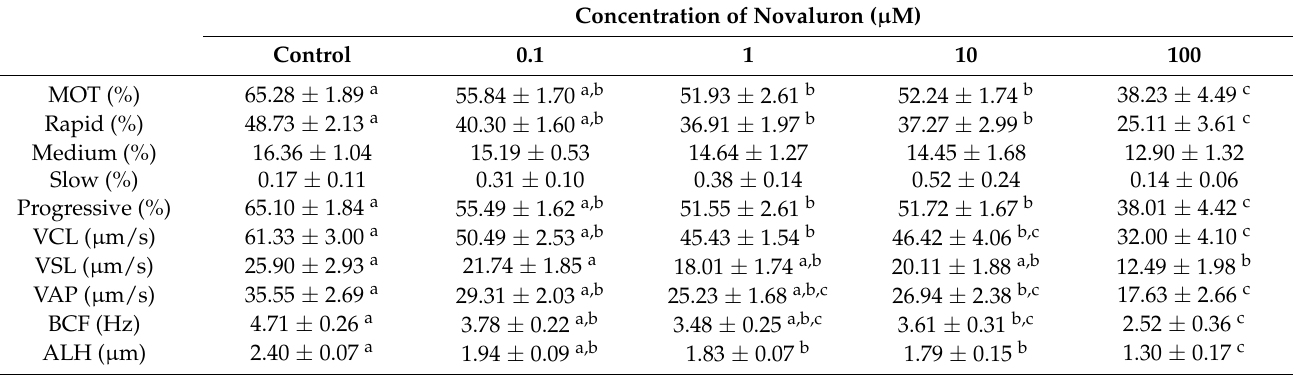
Table 1. Effects of novaluron on sperm motility and motion kinematics.